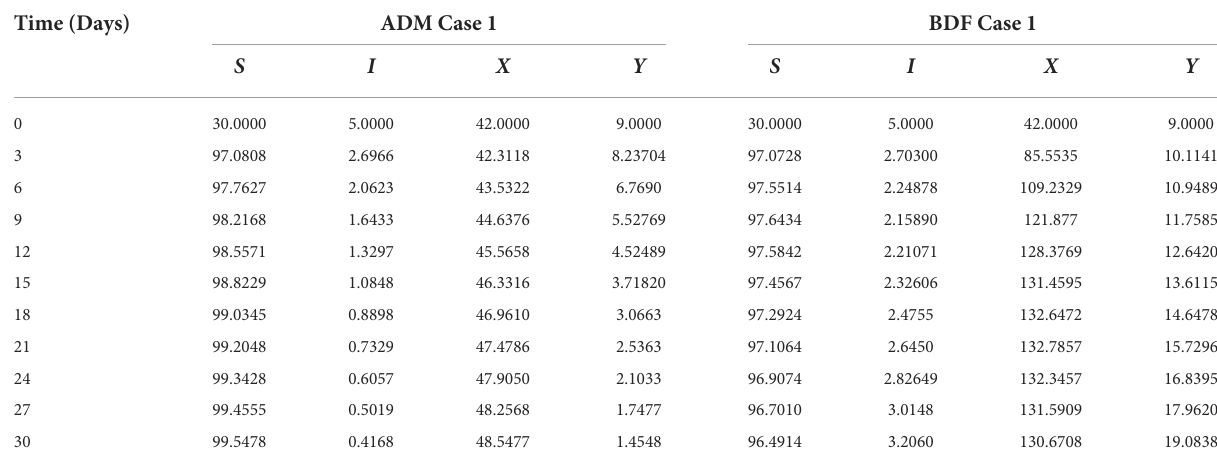
TABLE 7 Numerical outcomes of non-linear PVPMV model B1 for case-1 of scenario 5. Time (Days) ADM Case 1 BDF Case